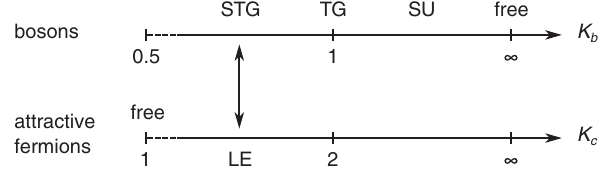
FIG. 11. Phase diagram of 1D bosons (top) and 1D spinless attractive fermions (bottom) with respect to the Luttinger param- eter K . The vertical arrow represents the mapping of the b;c attractive fermions in the Luther-Emery (LE) phase to the super- Tonks-Girardeau gas (STG) discussed in the text. Bosons realize < 1 , hard-core Tonks-Girardeau (TG) phase the STG phase at K b 1 , and a superfluid of weakly repulsive bosons (SU) at at K b ¼ ≫ 1 ; the free boson limit is realized at K → ∞ . The fermions K b b 1 , and attractive at K < 1 , free at K > 1 . are repulsive for K c c ¼ c The dashed region of the phase diagram corresponds to the regime where the boson-to-fermion mapping breaks down due to fluctuations of the spin field.